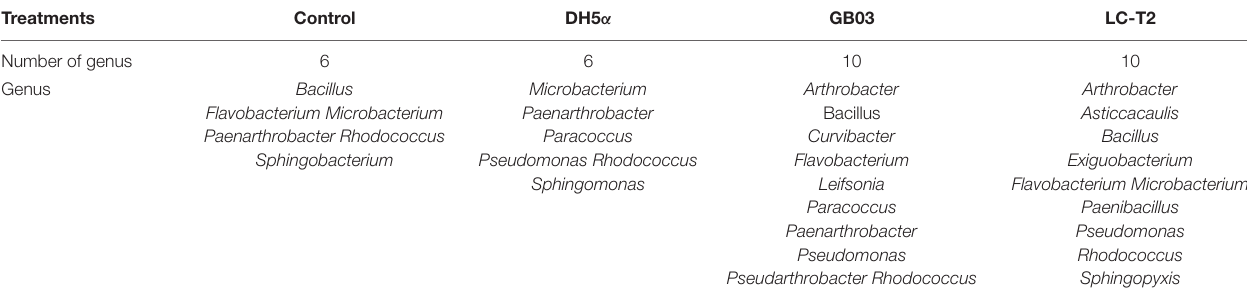
TABLE 4 | The number of genera counted from isolates in the white clover rhizosphere soil.